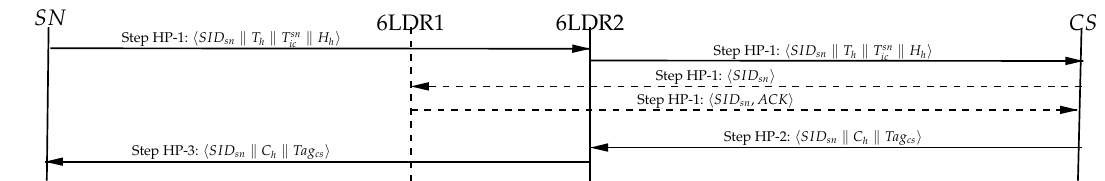
Figure 4. The S6AE handover